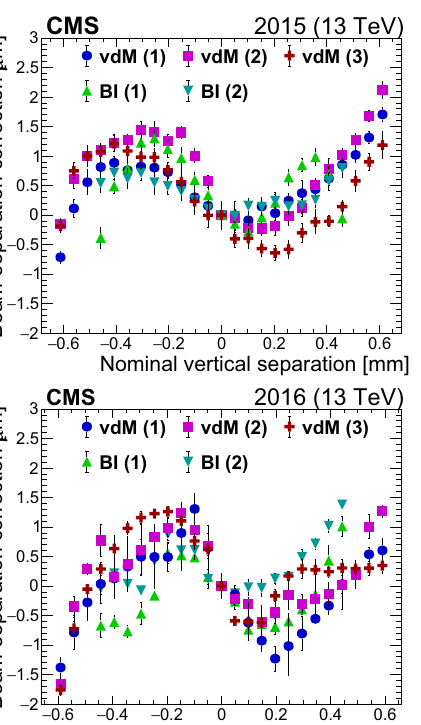
First-order polynomial fits are subsequently made to the input from BPMs (dots) and are used to estimate the orbit drift at each scan step. Slow, linear orbit drifts are corrected exactly in this manner, and more discrete discontinuities are corrected on average